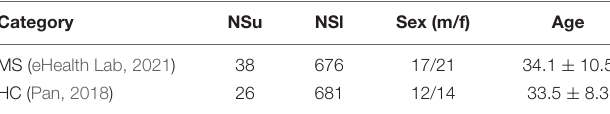
TABLE 1 | Demographic